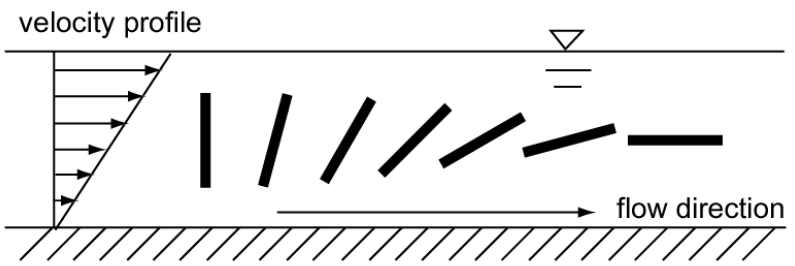
Figure 4. Schematic diagram of fiber rotational movement in a simple shear flow.